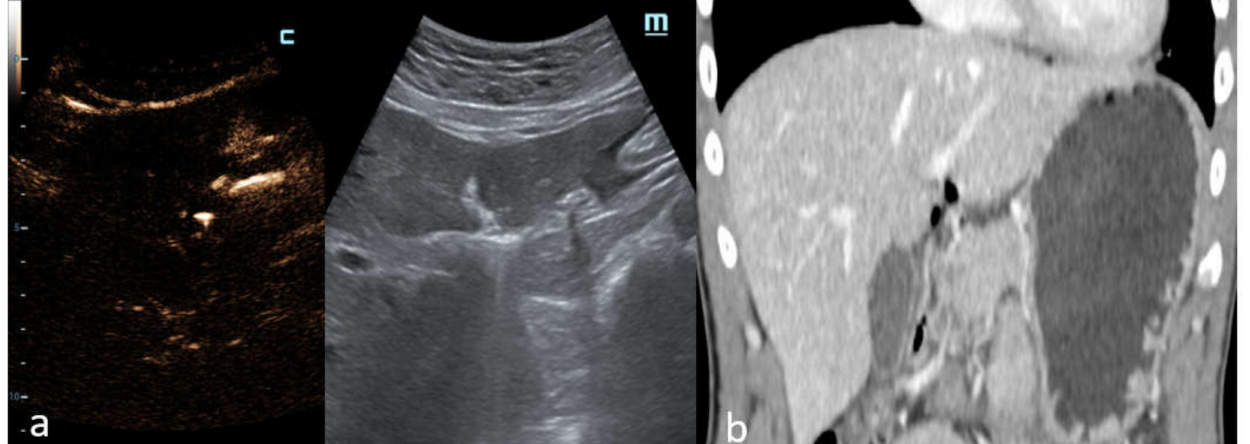
Figure 6. Male patient, 35 years of age with abdominal pain and a prolonged history of alcohol abuse. ( a ) Intercostal US scan of gallbladder region with depiction of C-mode and B-mode images. Free abdominal air around the duodenum and the pancreatic head is documented. ( b ) Coronal MPR reconstruction of abdominal CT in the venous phase shows increased thickness and focal discontinuity of the second tract of the duodenal wall; extra-luminal free air is also detected. Surgery revealed the presence of pyloric ulcerated